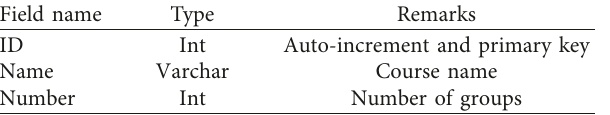
Table 8: Secondary indicators of performance